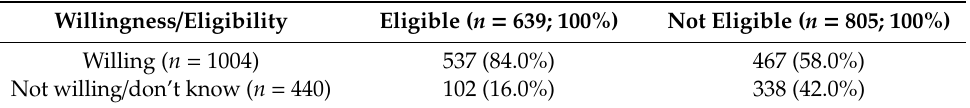
Table 3. Eligibility and willingness